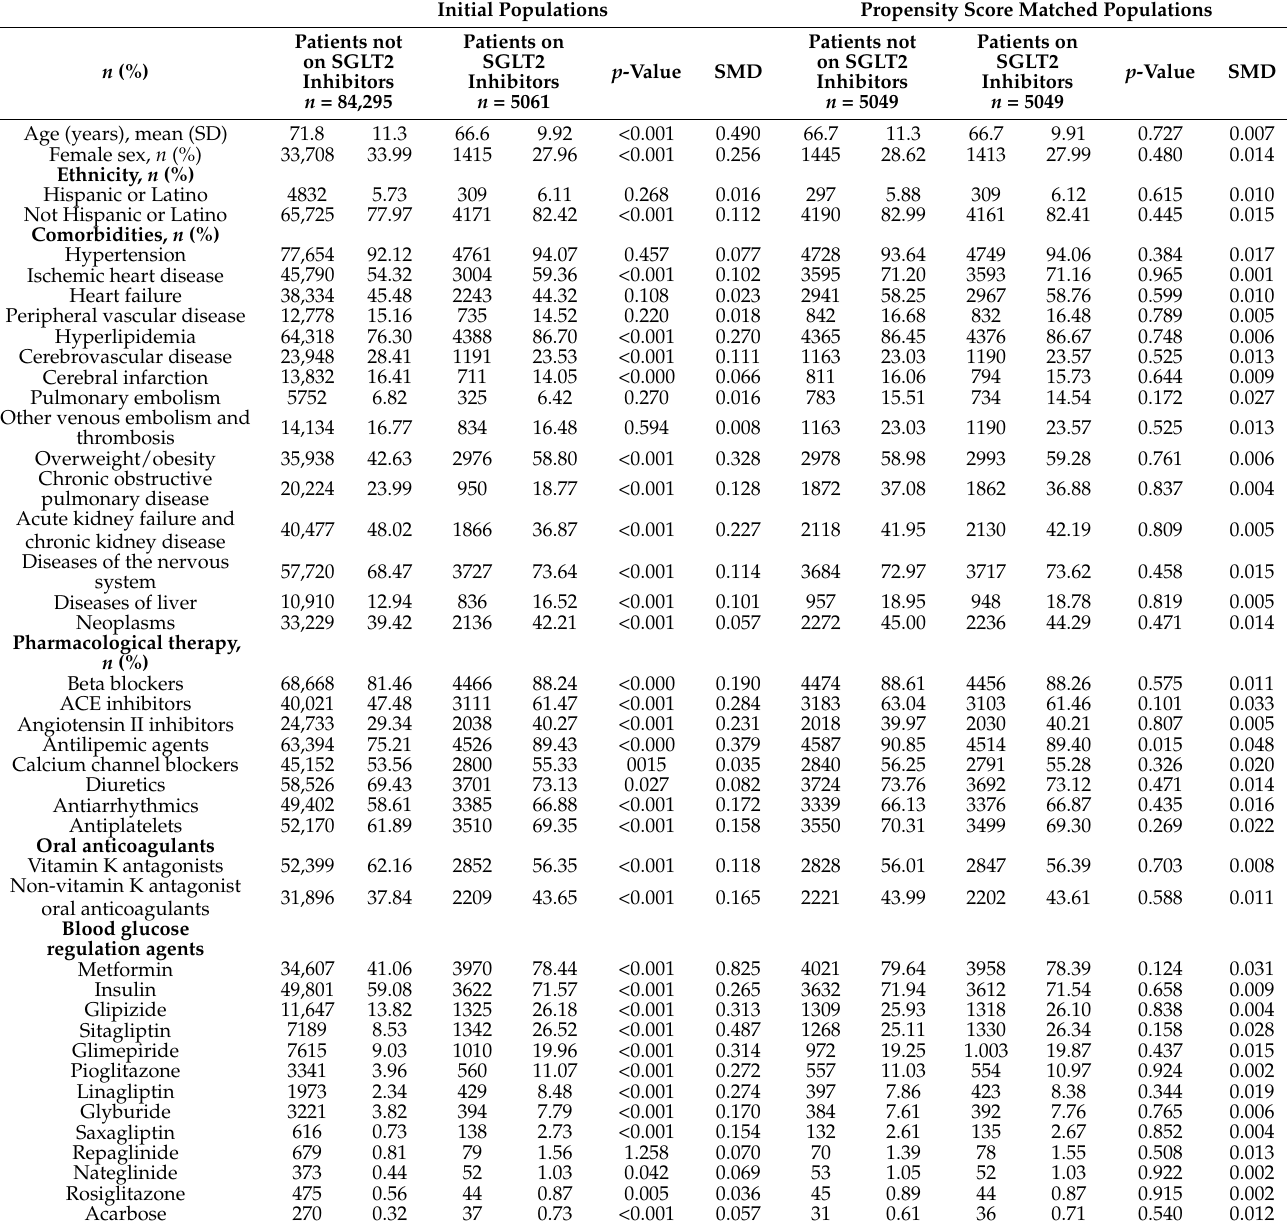
Table 1. Comparison of baseline clinical characteristics of the study cohort before and after propensity score matching. Initial Populations Propensity Score Matched